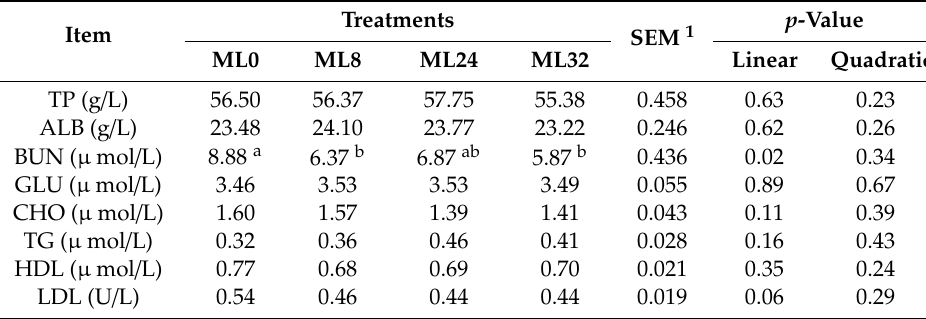
Table 5. E ff ects of inclusive ML treatments on blood metabolites of sheep.